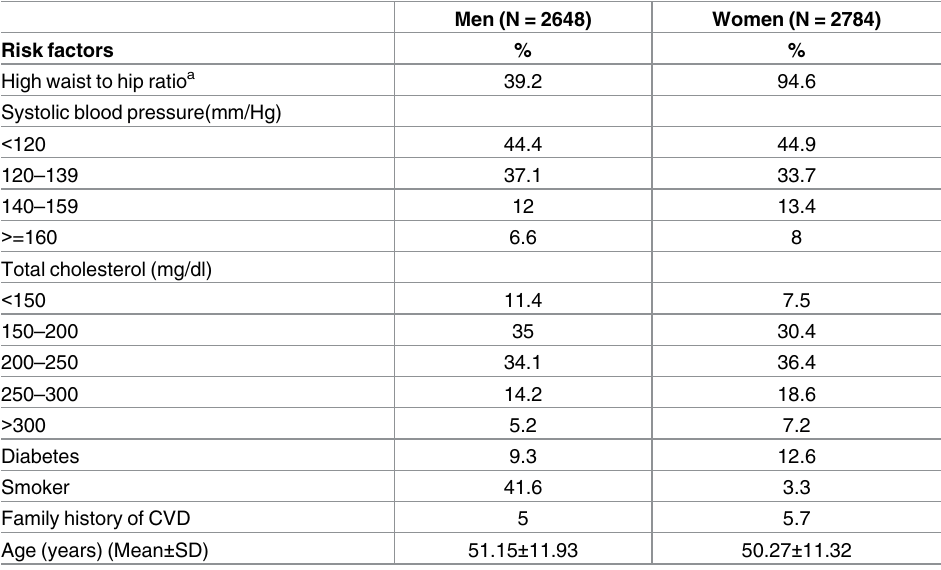
Table 1. Baseline characteristics of the study participants, ICS, 2001–2011.